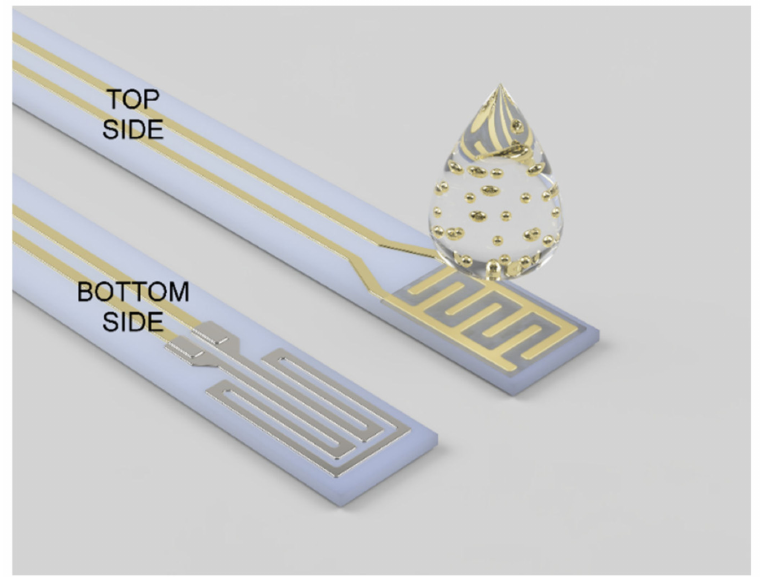
Figure 1. A render of the top and bottom layer of the ceramic substrate. The β -Ga 2 O 3 epitaxial layer grown on the gold interdigitated electrodes was later impregnated with an aqueous colloidal solution of Au nanoparticles. The platinum heater made on the bottom of the substrate was covered with a thick dielectric film (not shown in the